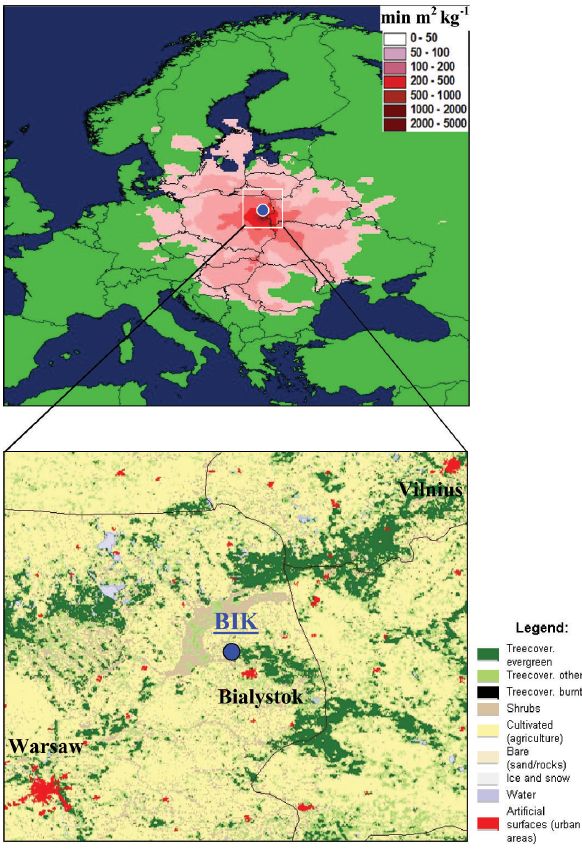
Fig. 1. a) Footprint area of the Bialystok tall tower station (level 300ma.g.l.), for the year 2005, estimated for CO 2 with the COMET model (figure courtesy A. Vermeulen, ECN Netherlands). The units are relative to a total of 10 6 and signify the relative contribution of unit of flux to the mole fraction variation (in ppm) observed at Bia- lystok; b) Land cover in the surroundings of the station. Map from Globalis.gvu.unu.edu (data source: GLC2000 – European Commis- sion, Joint Research Centre,